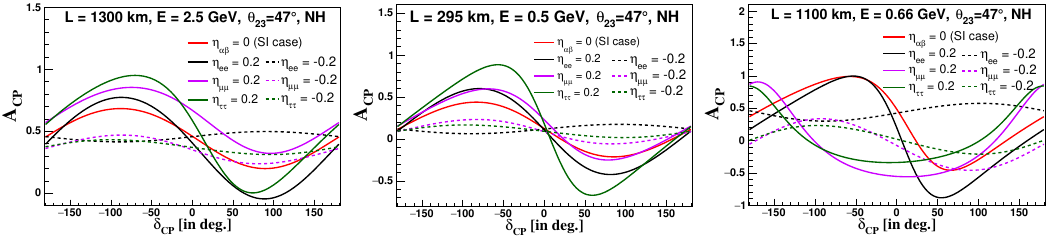
Figure 2 . The CP-asymmetry vs δ CP plot for DUNE (left-panel), T2HK (middle-panel) and T2HKK (right-panel) in presence of η mass hierarchy = NH. In all the three plots, the solid-red curve is for no scalar NSI case and other coloured solid (dashed) curves are for chosen positive (negative) η